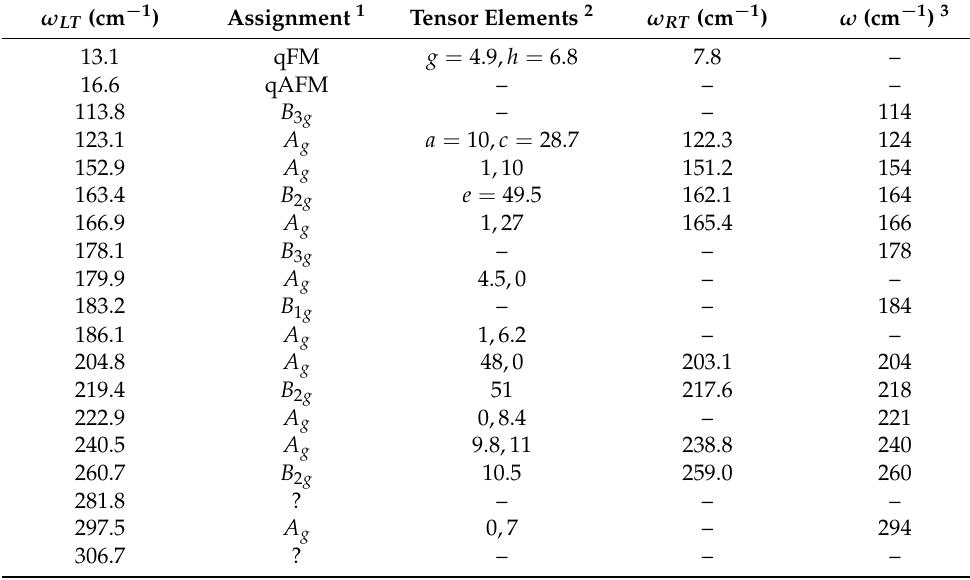
Table 1. Experimentally observed frequencies of magnetic and phonon excitations at T = 4.2 and 300 K. To increase the signal-to-noise ratio, frequency values were extracted from the angular-integrated polar dependencies. ω LT (cm − 1